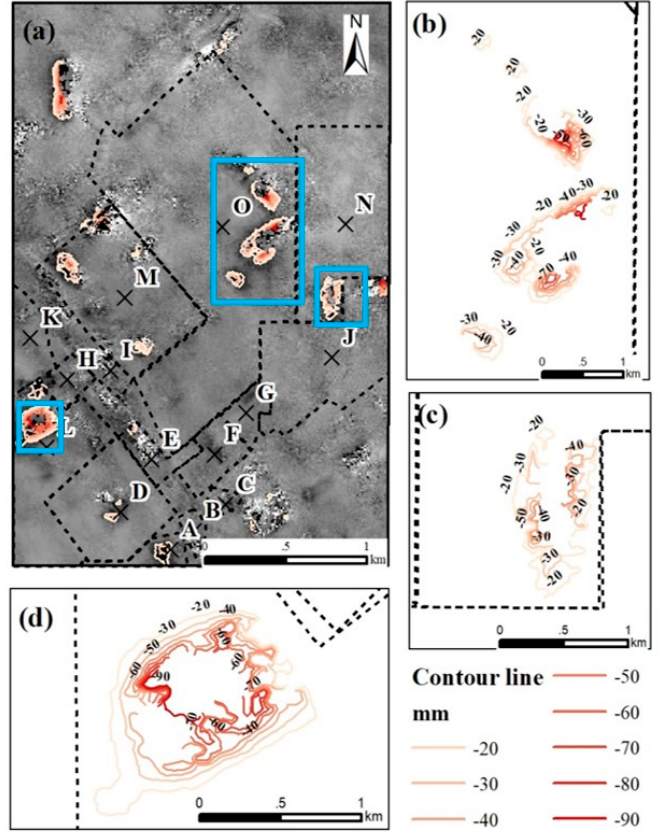
Figure 11. ( a ) Map of the deformation contours obtained from the cumulative displacement from December 2014 to July 2015; ( b – d ) the local deformation contours in the O, N and L coal mines.